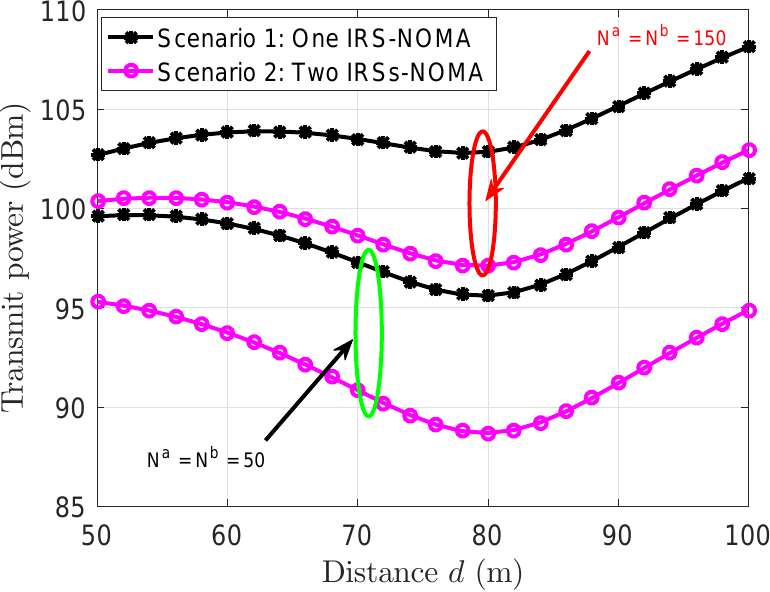
Figure 7. The required transmission power versus the achievable SE for